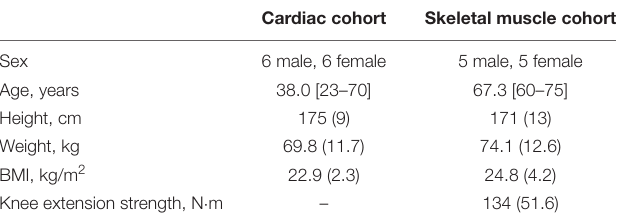
TABLE 1 | Participant